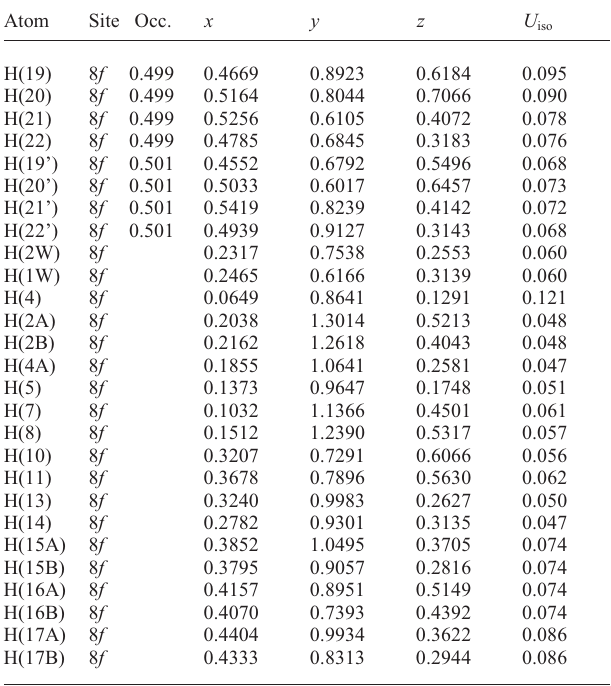
Table 2. Atomic coordinates and displacement parameters (in Å 2 )